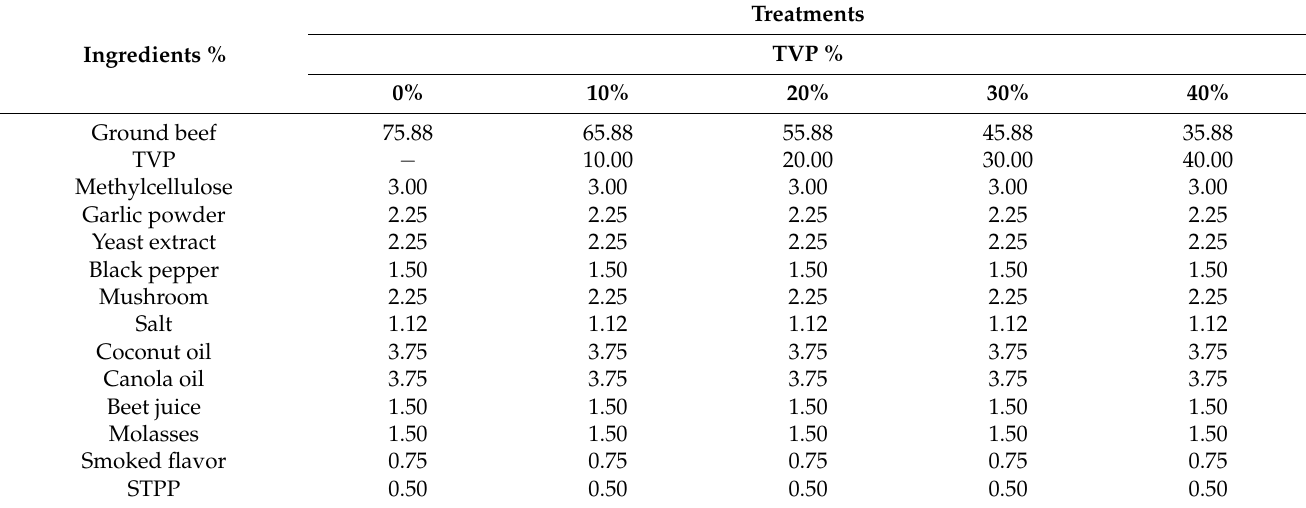
Table 1. Treatment and formulation of beef patties replaced with different levels of TVP.